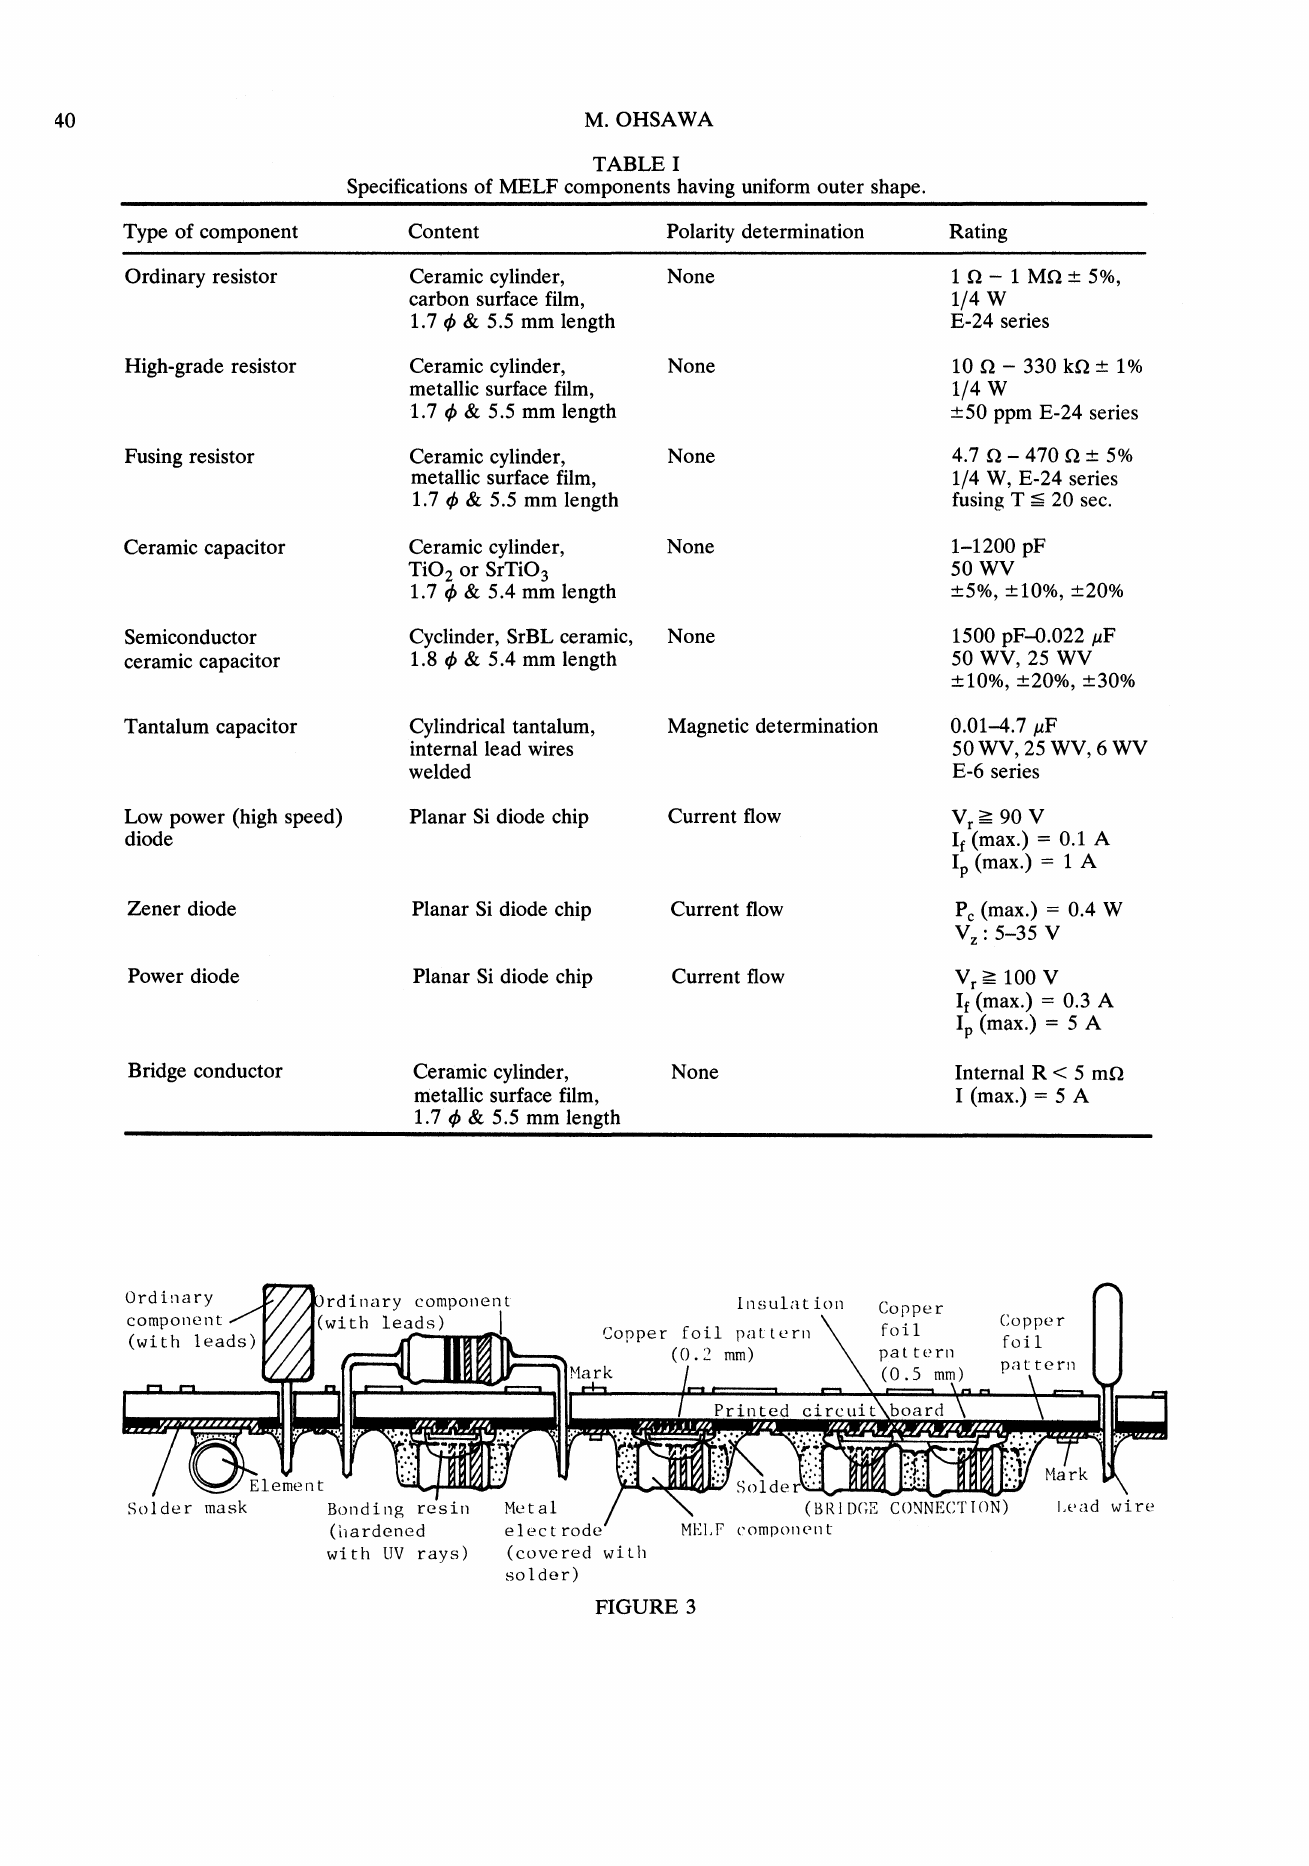
TABLE Specifications of MELF components having uniform outer